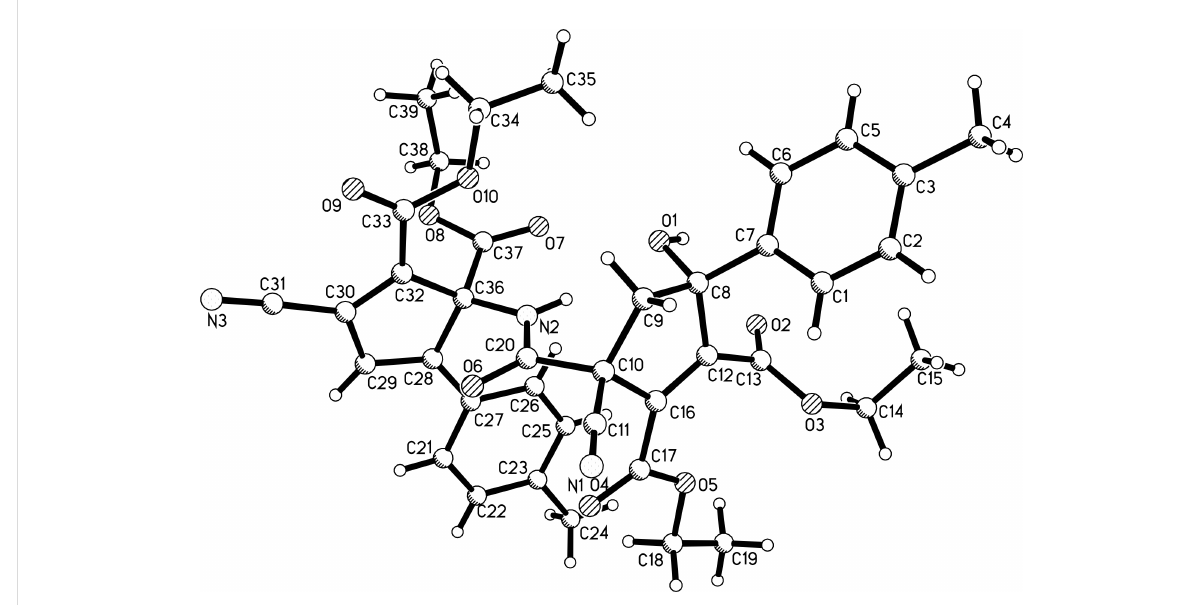
Figure 3: Single crystal structure of compound 4c .